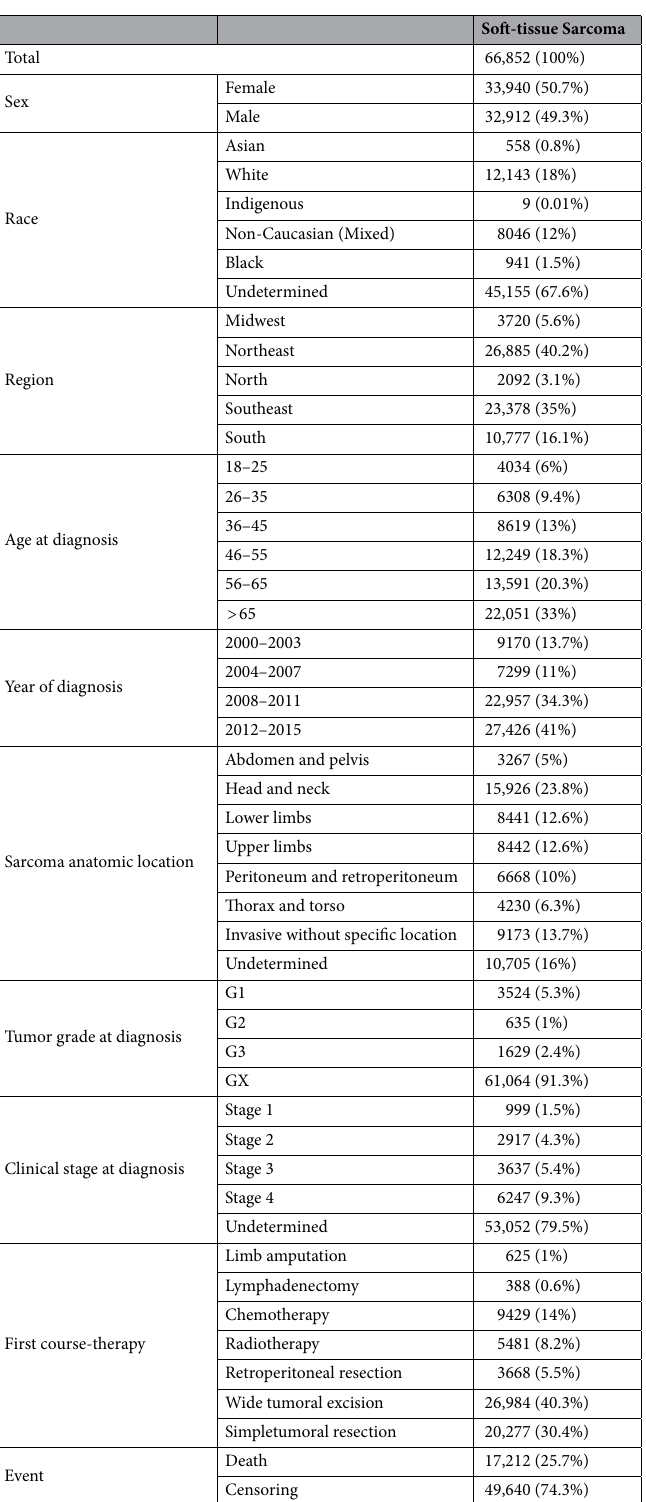
Table 1. Epidemiologic Aspects of the Sarcoma Patient in